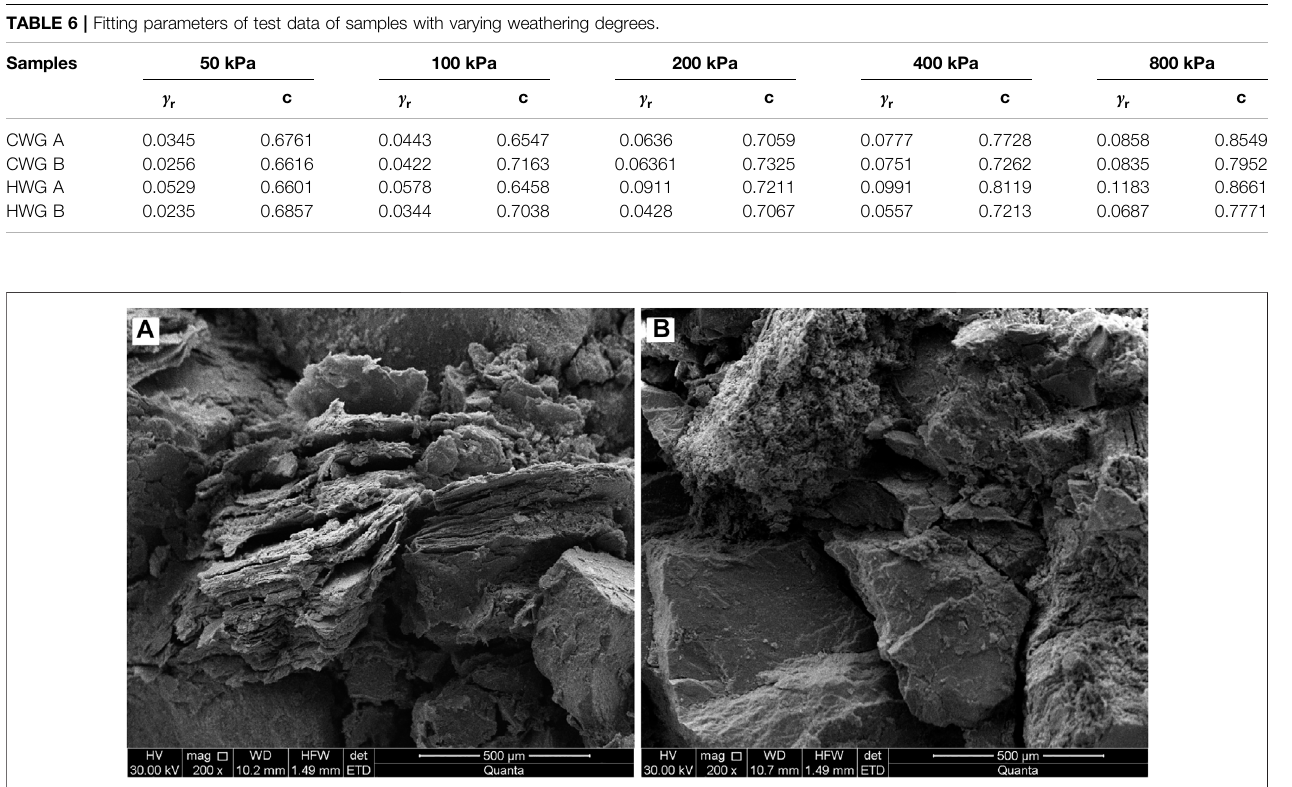
Frontiers in Earth Science |